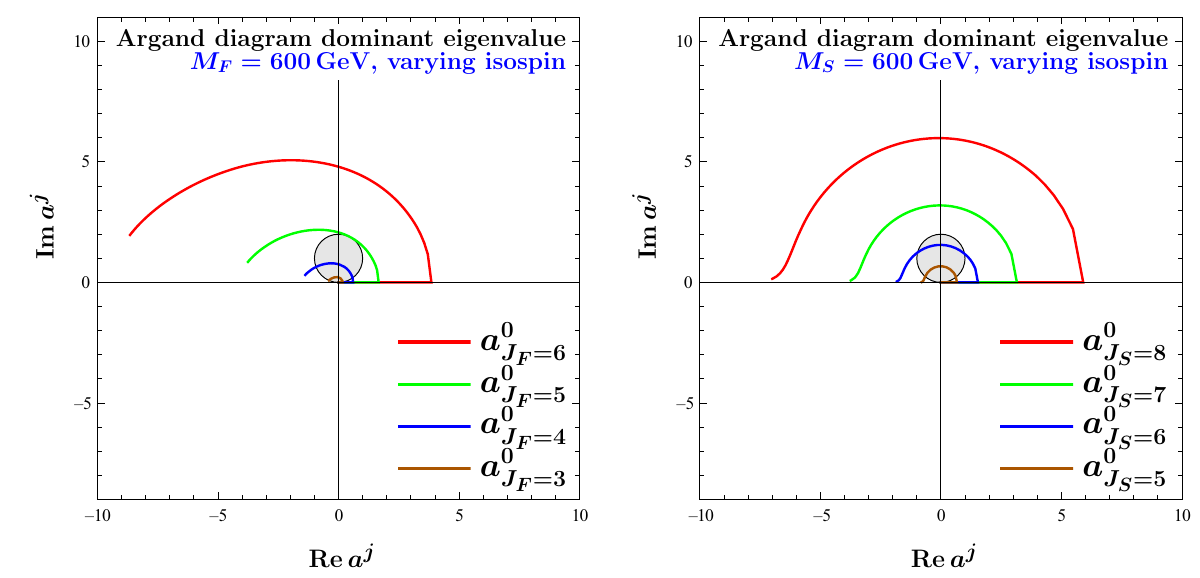
Fig. 3 Argand diagrams for the dominating iso-singlet, j = 0 VBS partial wave amplitudes, a 0 (scalar) multiplet of isospin J F ( J S ) of mass M R = 600 GeV. Only the BSM contribution to the amplitude is shown